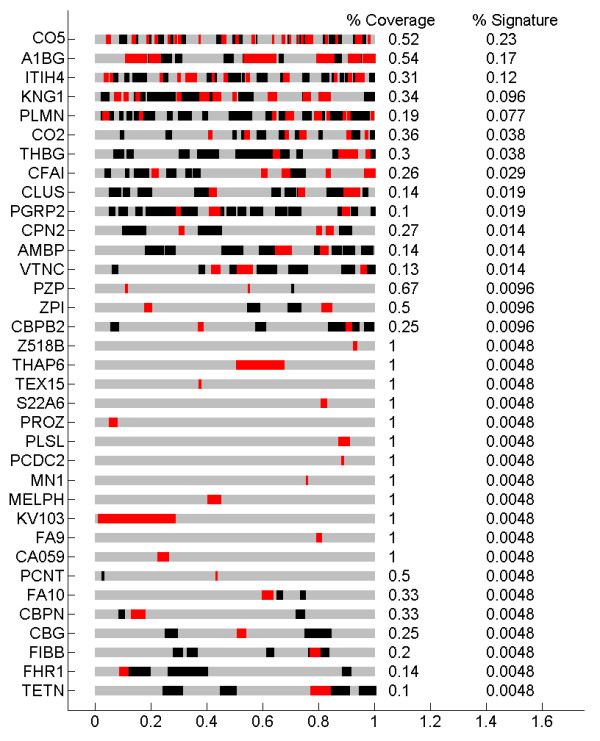
Predictor content. Shows the locations of the 600 most used peptides which were also identified. Proteins with fewer than 1% of their peptides represented in the figure were filtered out.